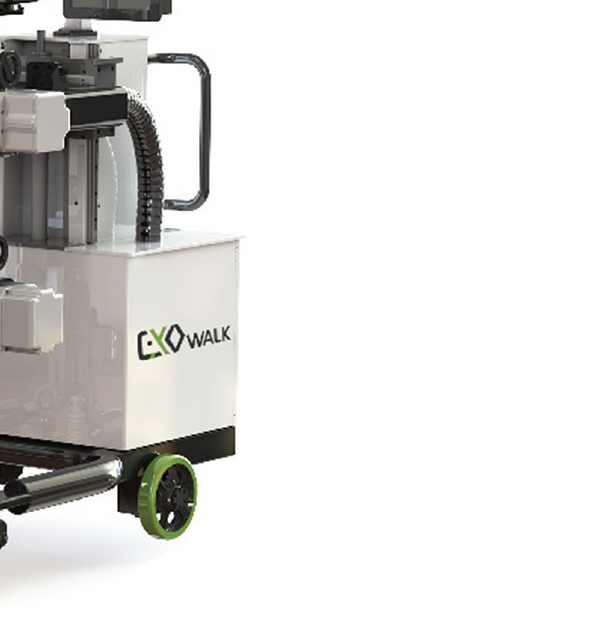
Figure 1. EXOWALK (HMH Co. Ltd, South